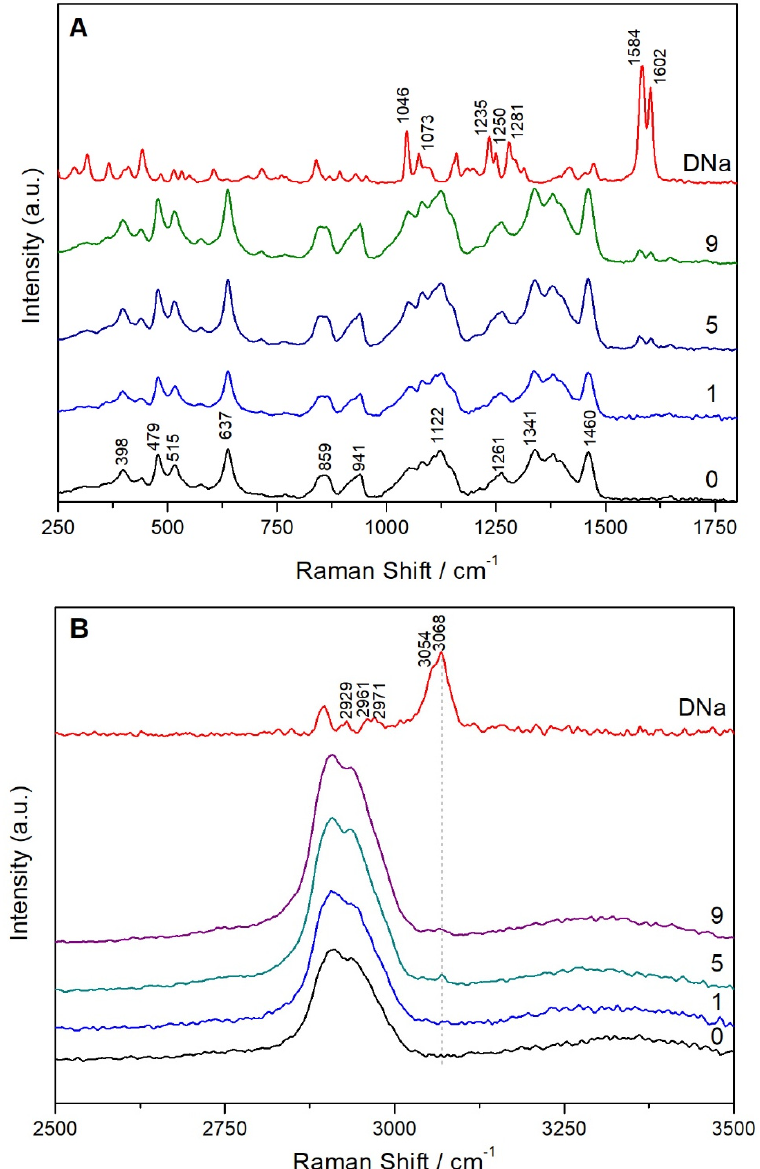
Figure 5. FT ‐ Raman spectra in the range of 250–1800 cm − 1 ( A ) and 2500–3500 cm − 1 ( B ) of DNa; plain sugar sheet (0); and films printed with 1, 5, and 9 passes.